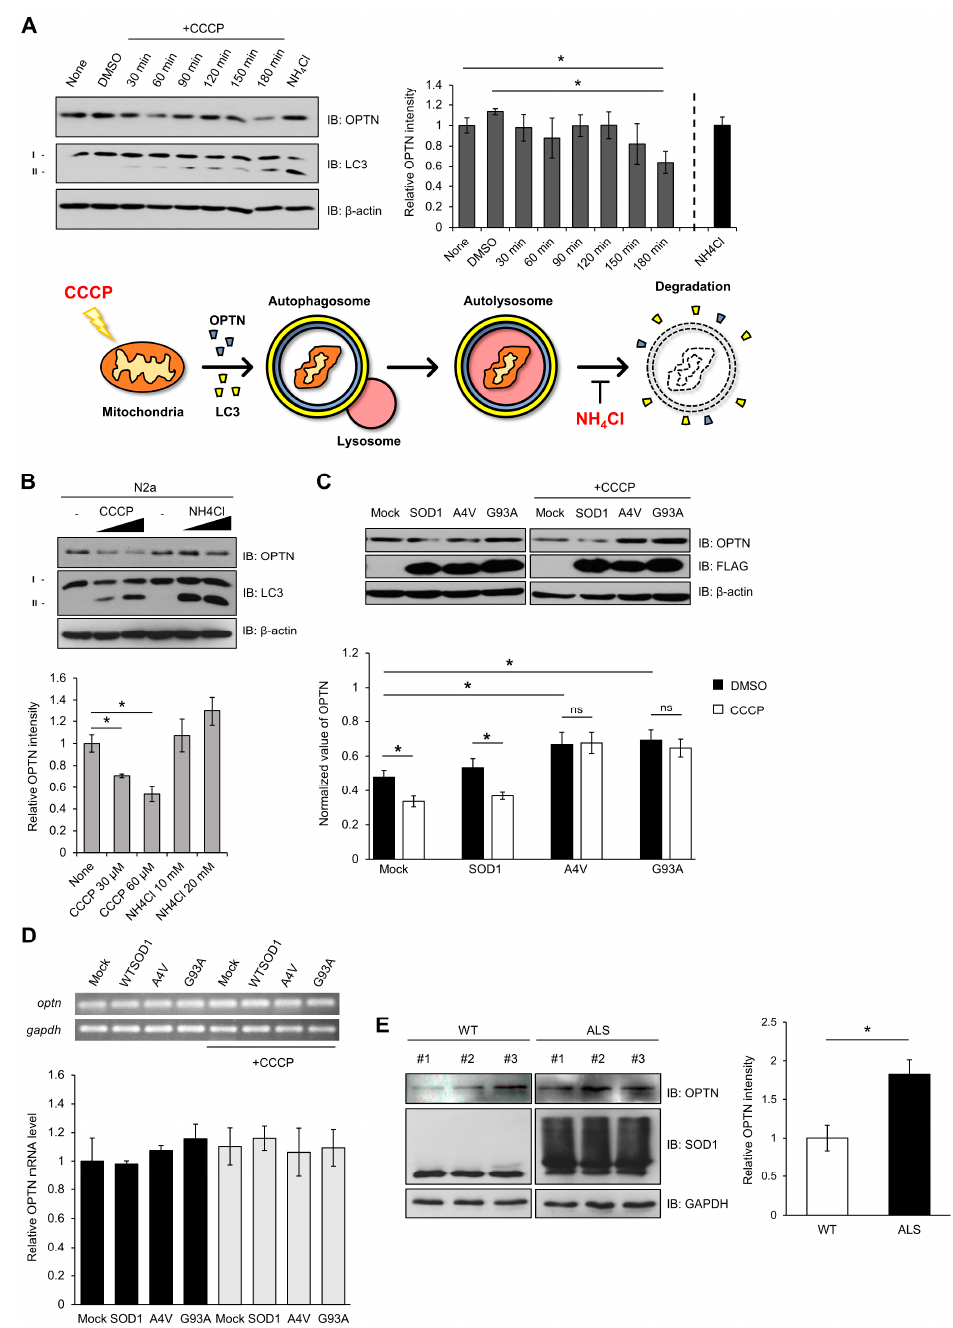
Figure 3. Mutant SOD1 aggregates lead to accumulation of optineurin, required for mitophagy. ( A ) N2a cells were lysed and immunoblotted using anti-OPTN, anti-LC3, and anti- β -actin after being treated with CCCP (30 μ M) in a time-dependent manner, or NH 4 Cl (10 mM, 3 h). The results were normalized to β -actin. ( B ) Quantitation of the endogenous OPTN levels in N2a cells following CCCP or NH 4 Cl treatment for 3 h in a different concentration. ( C ) Quantitation of the endogenous OPTN levels in N2a cells expressing FLAG-SOD1, FLAG-A4V, FLAG-G93A, and FLAG. At 48 h after transfection, each sample was immunoblotted against specific antibodies in the absence or presence of CCCP treatment (20 μ M, 12 h). ( D ) The levels of OPTN mRNA from the N2a cells expressing FLAG-SOD1, FLAG-A4V, FLAG-G93A, and FLAG were measured using quantitative PCR. CCCP treatment was applied (20 μ M, 12 h) to the cells at 48 h post transfection. The results were normalized to GAPDH. ( E ) Quantitation of the OPTN level from the spinal cords of 16-week-old SOD1-G93A mice and control mice. The results were normalized to GAPDH. n = 3 per group. * p <